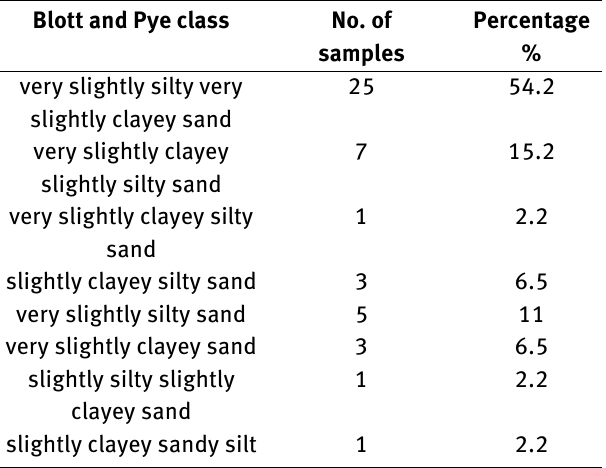
Table 4: Blott and Pye soil classification for Tigris River bed sam- ples